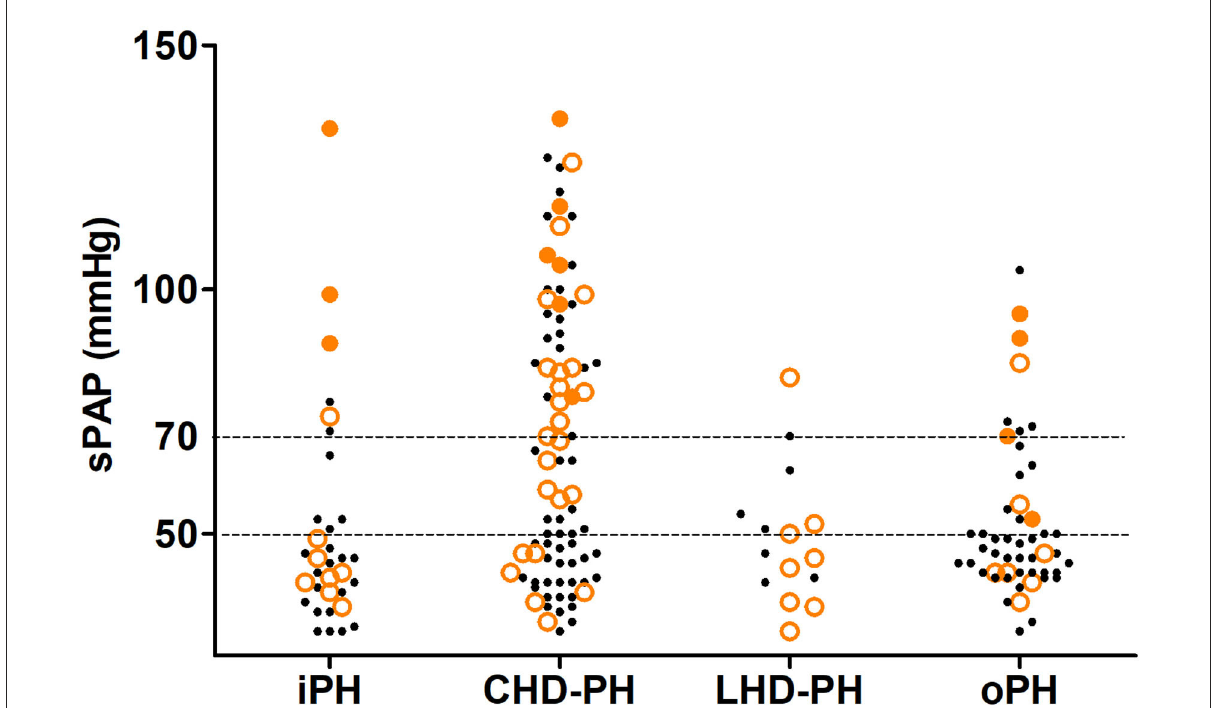
FIGURE2 In-hospital outcome of the pregnancy and different severities of pulmonary hypertension in the study population based on the related disease. The small black dots represent the cases without MACE, the lager orange circles represent the cases that experience MACE, and the large orange dots represent the cases that experience in-hospital death. CHD-PH, patients with the previous history of congenital heart disease; iPH, patients with an initial diagnosis of idiopathic pulmonary hypertension before this admission and without any known cause of pulmonary hypertension; LHD-PH, patients with a history of left ventricular systolic dysfunction but not congenital structural abnormality; MACE, major adverse cardiovascular events; oPH, pulmonary hypertension associated with other diseases; sPAP, systolic pulmonary arterial pressure estimated via